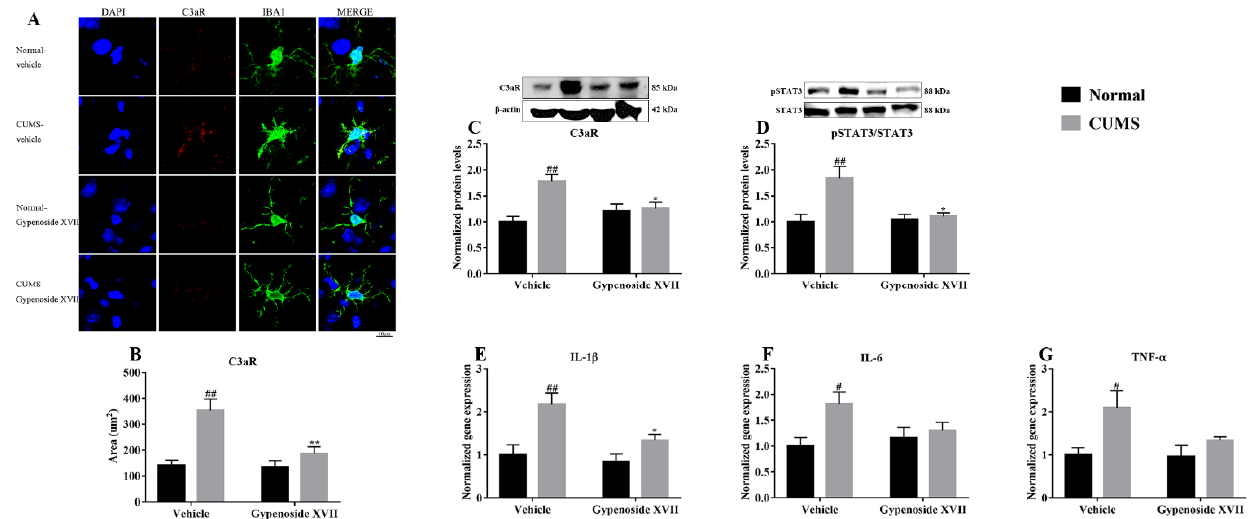
Figure 4. Gypenoside XVII inhibits C3aR-STAT3 cytokines signaling in the prefrontal cortex ( n = 4–6). C3aR levels were detected by both immunofluorescence ( A , B ) and Western blot ( C ). pSTAT3/STAT3 was detected by Western blot ( D ). The mRNA expression of IL-1 β ( E ), IL-6 ( F ) and TNF- α ( G ) was detected by PCR. # p < 0.05 and ## p < 0.01 versus the Normal-vehicle group. * p < 0.05 and ** p < 0.01 versus the CUMS-vehicle group.